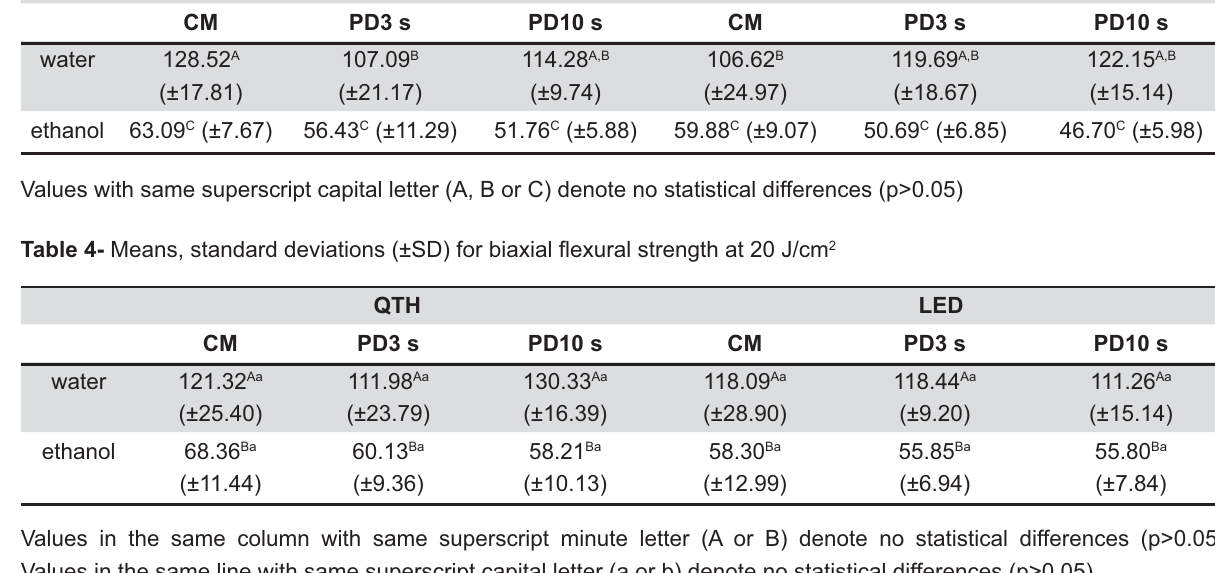
Values in the same column with same superscript minute letter (A or B) denote no statistical differences (p>0.05) Values in the same line with same superscript capital letter (a or b) denote no statistical differences